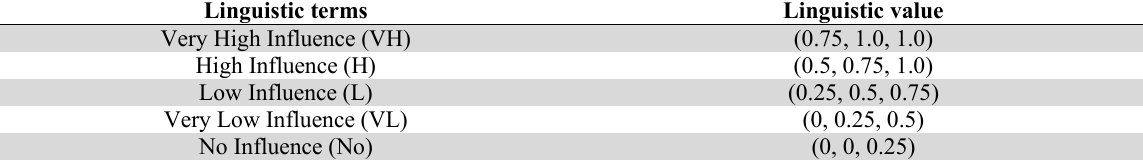
The correspondence of linguistic terms and linguistic values (Lin & Wu, 2004) Linguistic